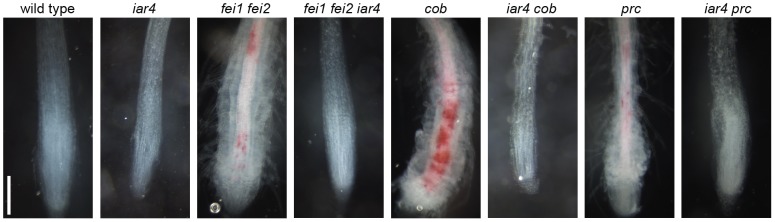

iar4 suppresses lignin accumulation in cell wall mutants.Phloroglucinol stain for lignin (red) accumulation in root tips of seedlings of the indicated genotype grown on 4.5% sucrose for 2 weeks. Scale bar = 1 mm.